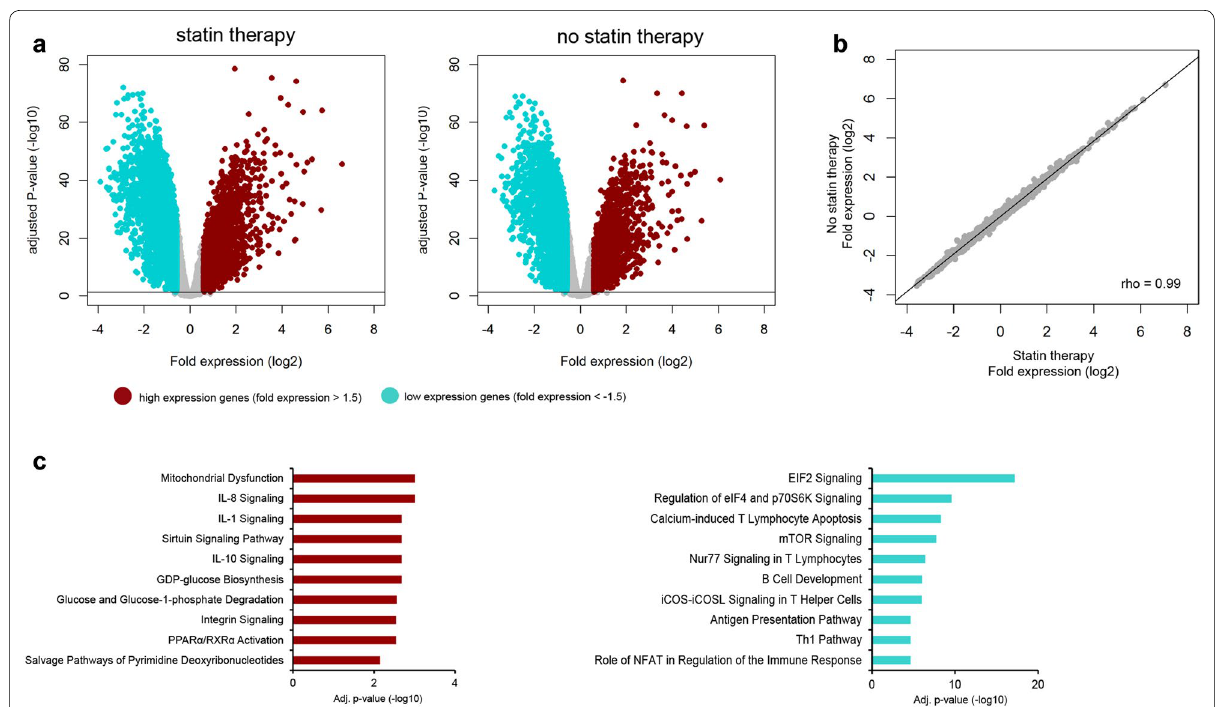
Fig. 4 Blood transcriptomics of sepsis patients discordant for statin therapy in the propensity-matched cohort. a Volcano plot representation of dif- ferential gene expression in patients treated with statins ( N 95) and patients not treated with statins ( N 95), both relative to healthy subjects. b = = Dot plot illustrating the strong correlation between expression changes in sepsis patients discordant for statin therapy, relative to healthy subjects. Rho, Spearman’s rho. c Ingenuity pathway analysis of genes with elevated expression (red bars) and decreased expression (turquoise) ( N =